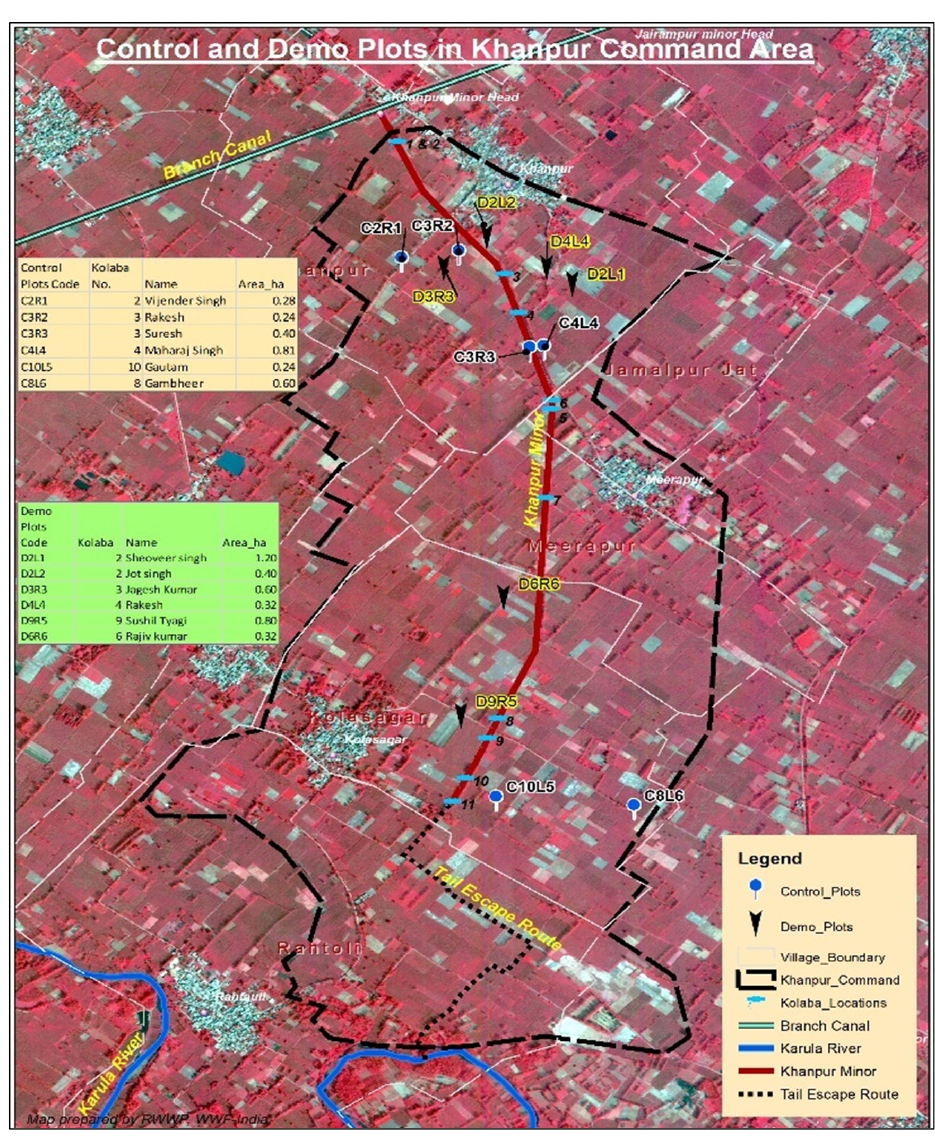
Figure A5. Khanpur Minor Command Area Map with Location of Control and Demonstration Figure A4. Khanpur Minor Command Area Map with Location of Control and Demonstration farms .